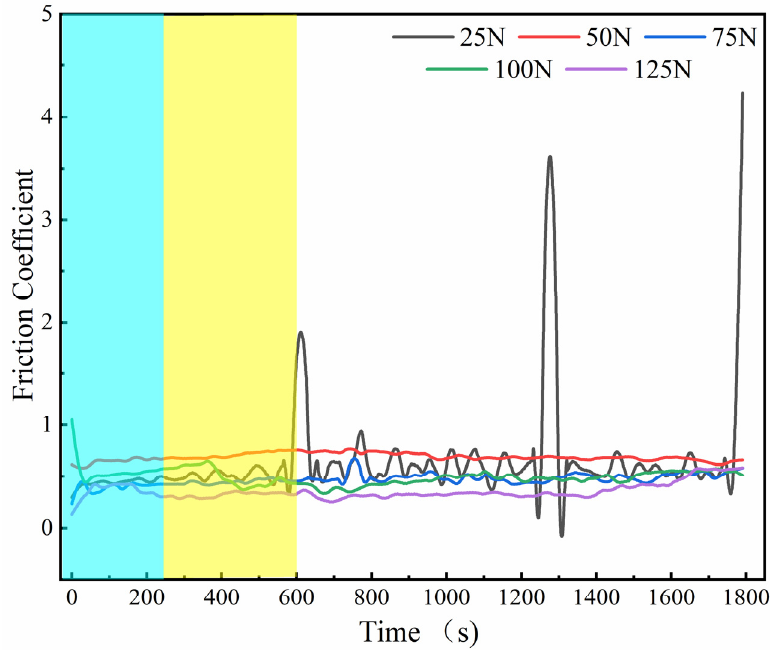
Figure 13. The curve of the friction coefficient of sample YG8-30 over time under various loads.